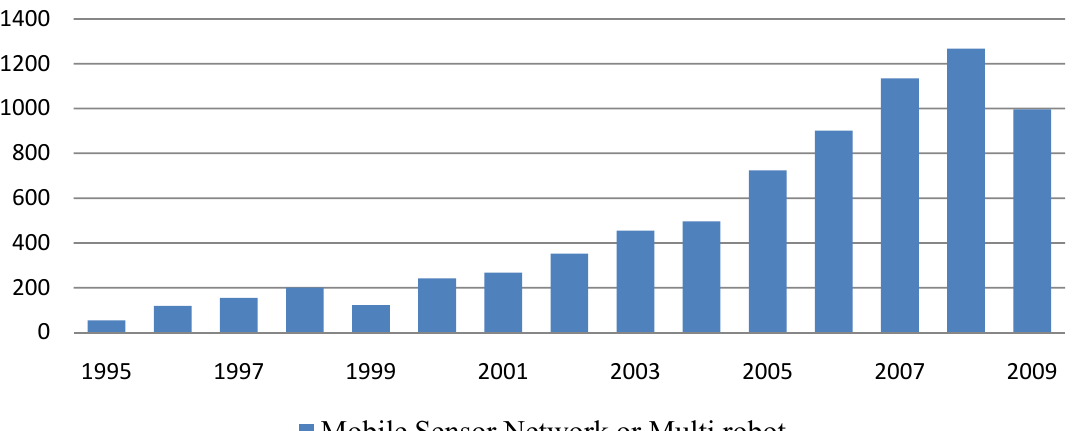
Figure 1. The number of publications on mobile sensor networking research in the Web of Science from 1995 to